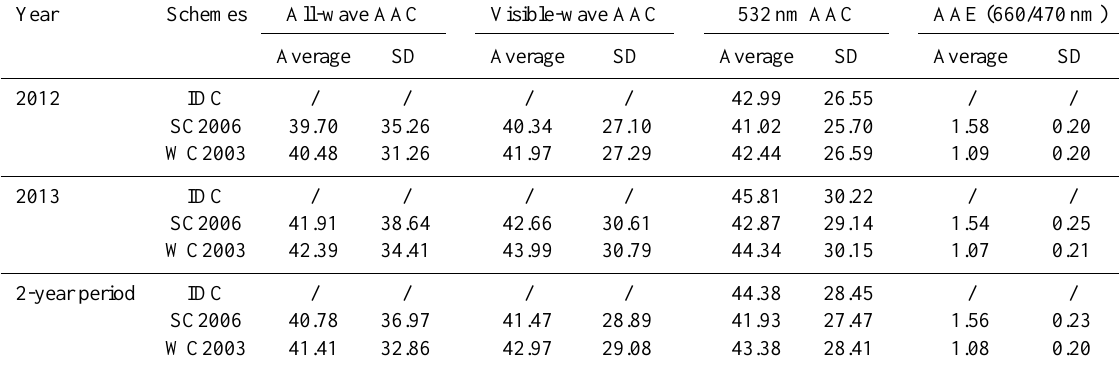
Table 1. Statistical values of annual aerosol absorption coefficient (Mm − 1 ) and absorption Ångström exponent in the urban area of Nanjing. Year Schemes All-wave